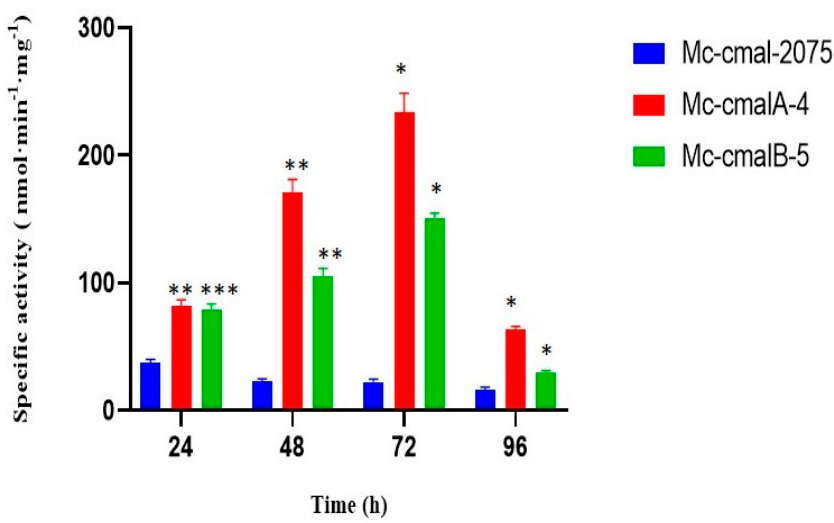
Figure 4. Specific ME activity of the control strain Mc-cmal-2075 and overexpressing strains Mc- cmalA-4 and Mc-cmalB-5. Values are the mean of three biological replicates. Error bars represent the standard error of the mean. Asterisks indicate significant differences: * p < 0.05, ** p < 0.01, *** p < 0.001.